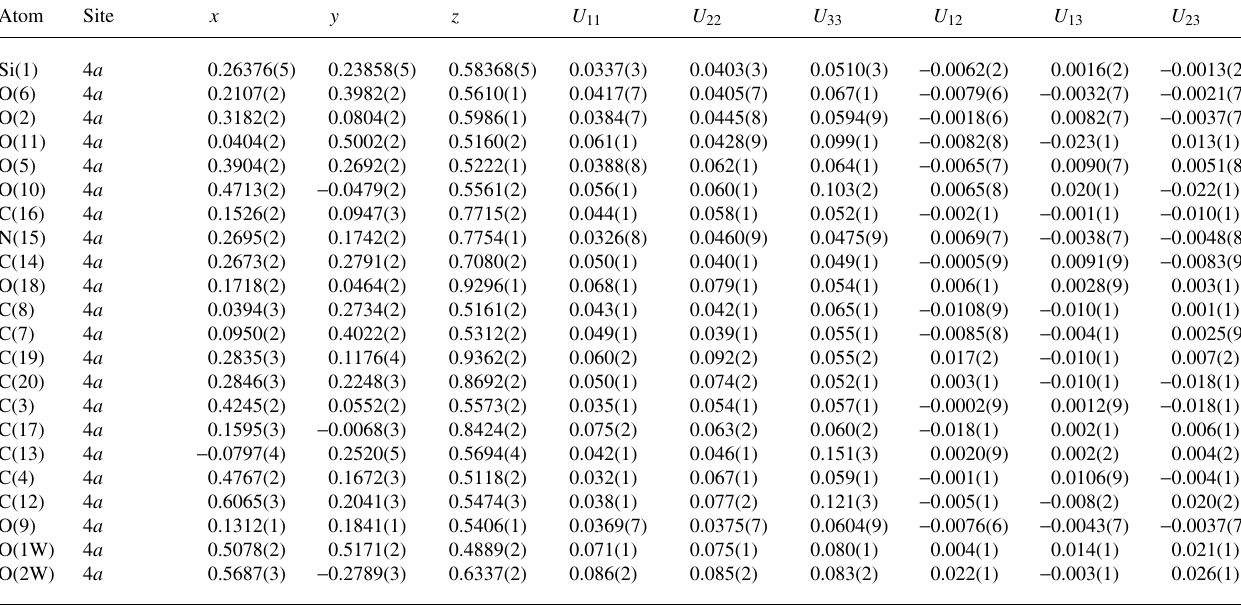
Table 3. Atomic coordinates and displacement parameters (in Å 2 ) .